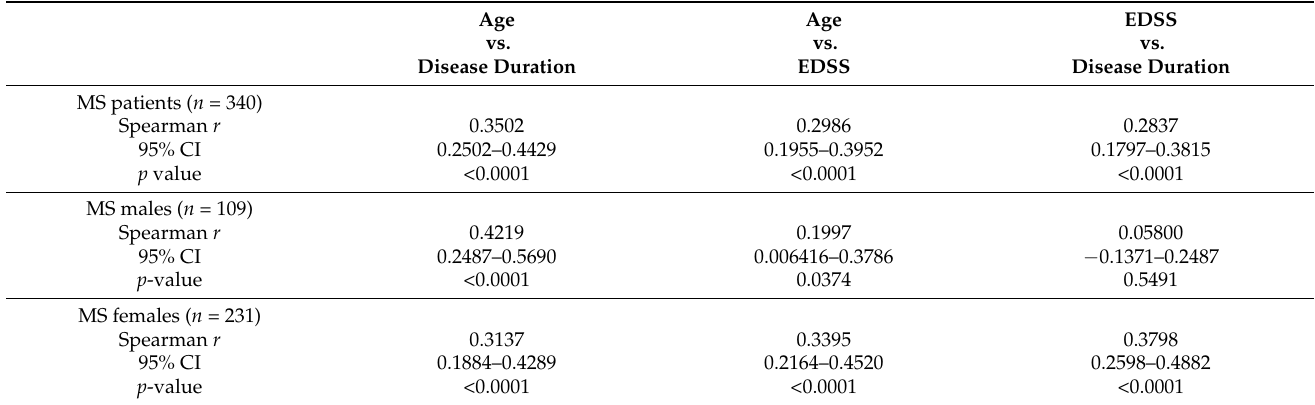
Table 3. Effect of age on disease duration and severity. Only multiple sclerosis (MS) patients were included (cohort 1 and cohort 2 together). Patients were analyzed as a whole and grouped by sex. Age vs. Disease Duration